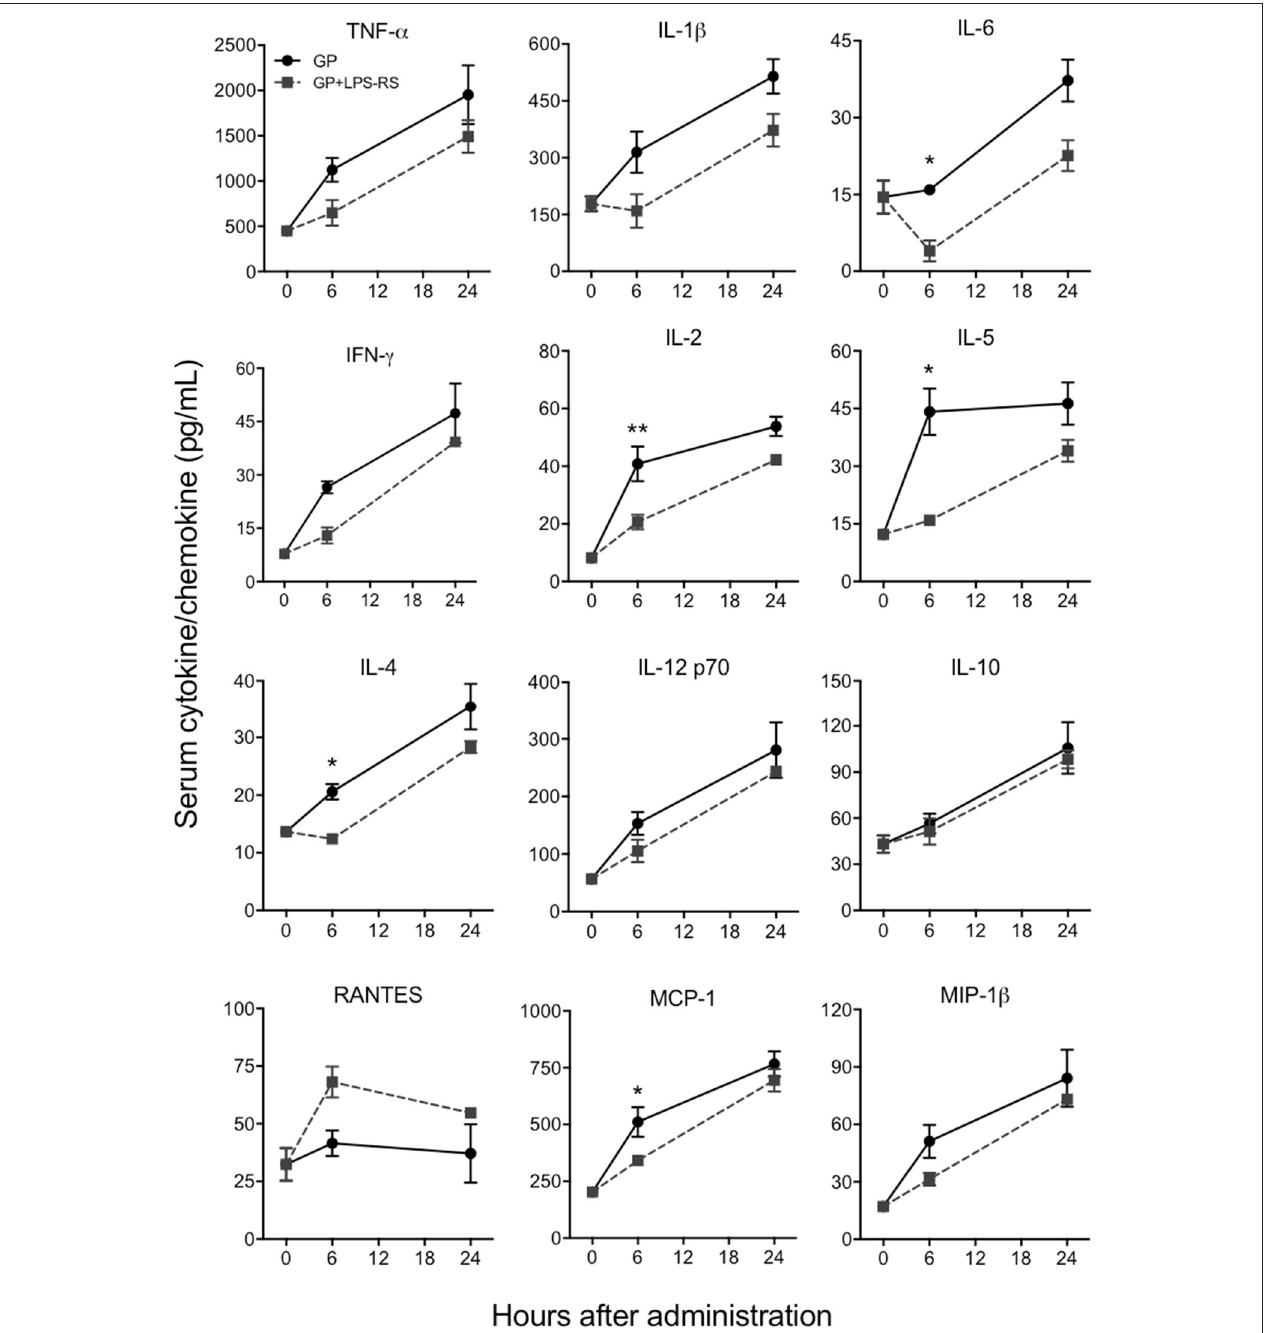
FIGURE 5 | EBOV GP induces innate immune responses via TLR4. C57BL/6 mice were pre-treated with LPS-RS (5 µ g per mouse) for 2 days prior to co-administration of 100 µ g GP and 10 µ g LPS-RS per mouse. Serum levels of multiple cytokines and chemokines were measured using a multiplex Luminex assay. The data are expressed as the mean concentration (pg/mL) ± SEM from at least 3 animals per group. Significance of differences between sera from GP and GP + LPS-treated mice was analyzed by two-way ANOVA followed by a Sidak’s multiple comparison test. * p < 0.05, ** p <